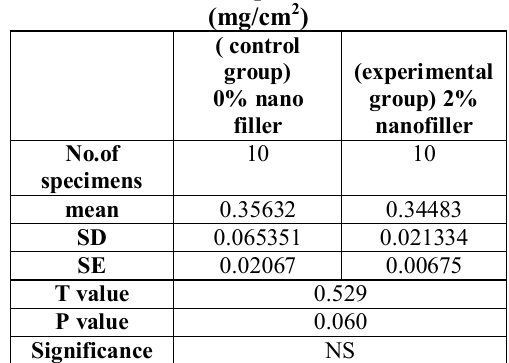
Table 5: water sorption test results in